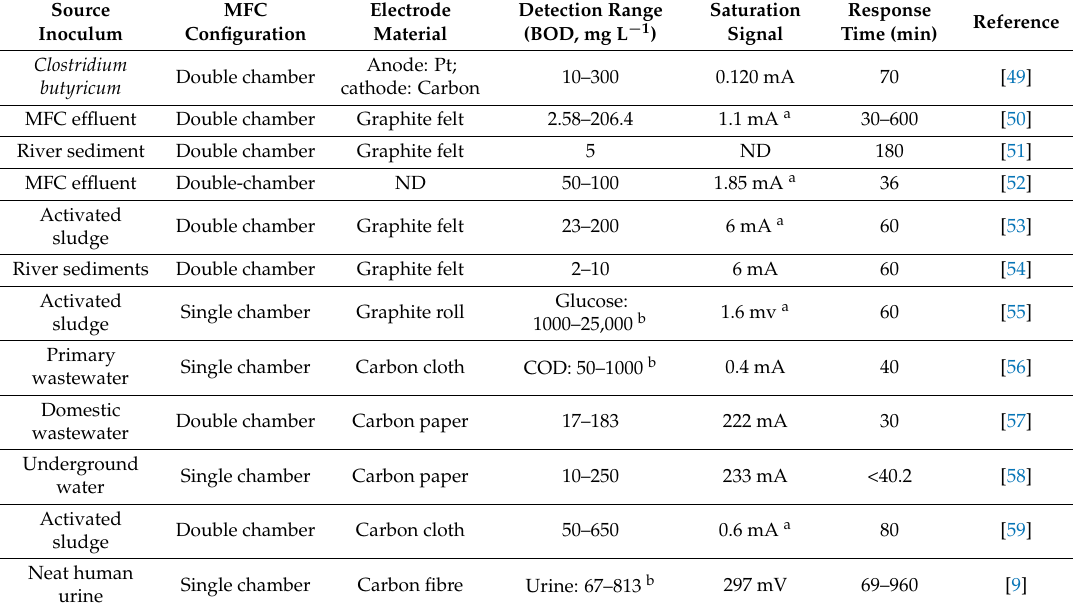
Table 1. MFCs as BOD biosensors.